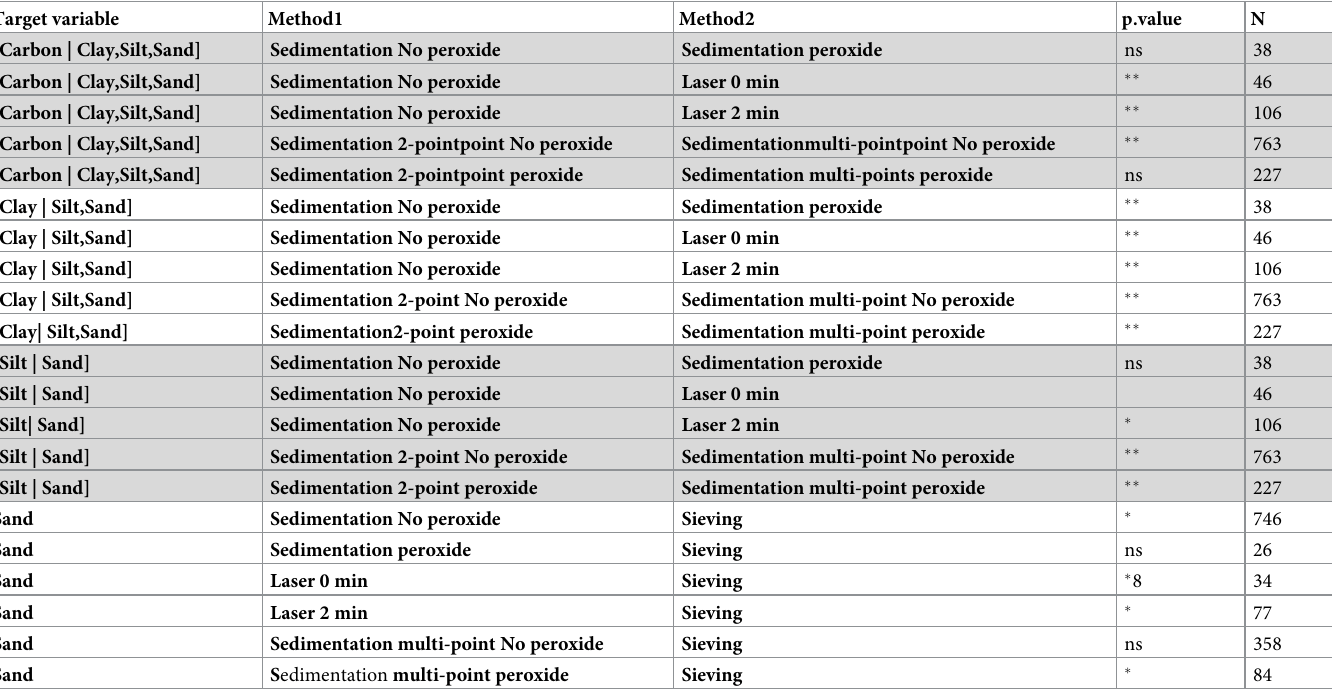
Table 2. Comparison of methods (method1 minus method2) using paired t-test and confidence intervals (p �